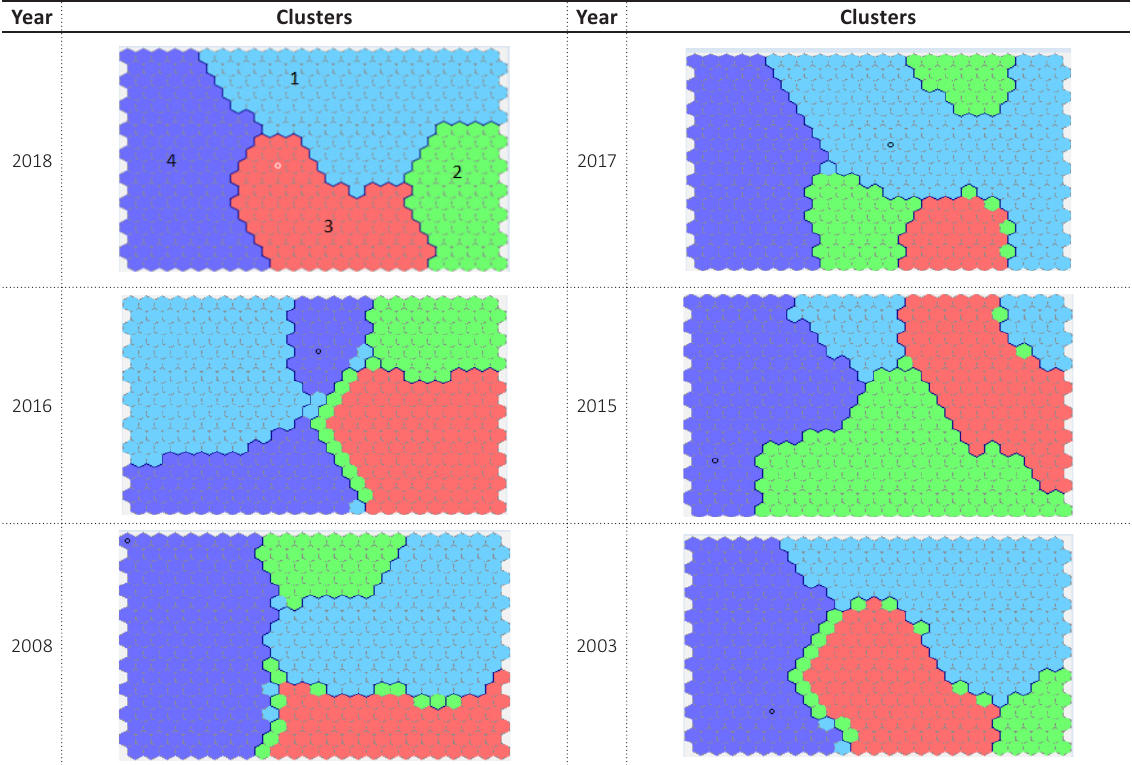
Figure 2. SOMs in the context of the grouping the countries according to their level of http://dx.doi.org/10.21511/imfi.17(1).2020.28